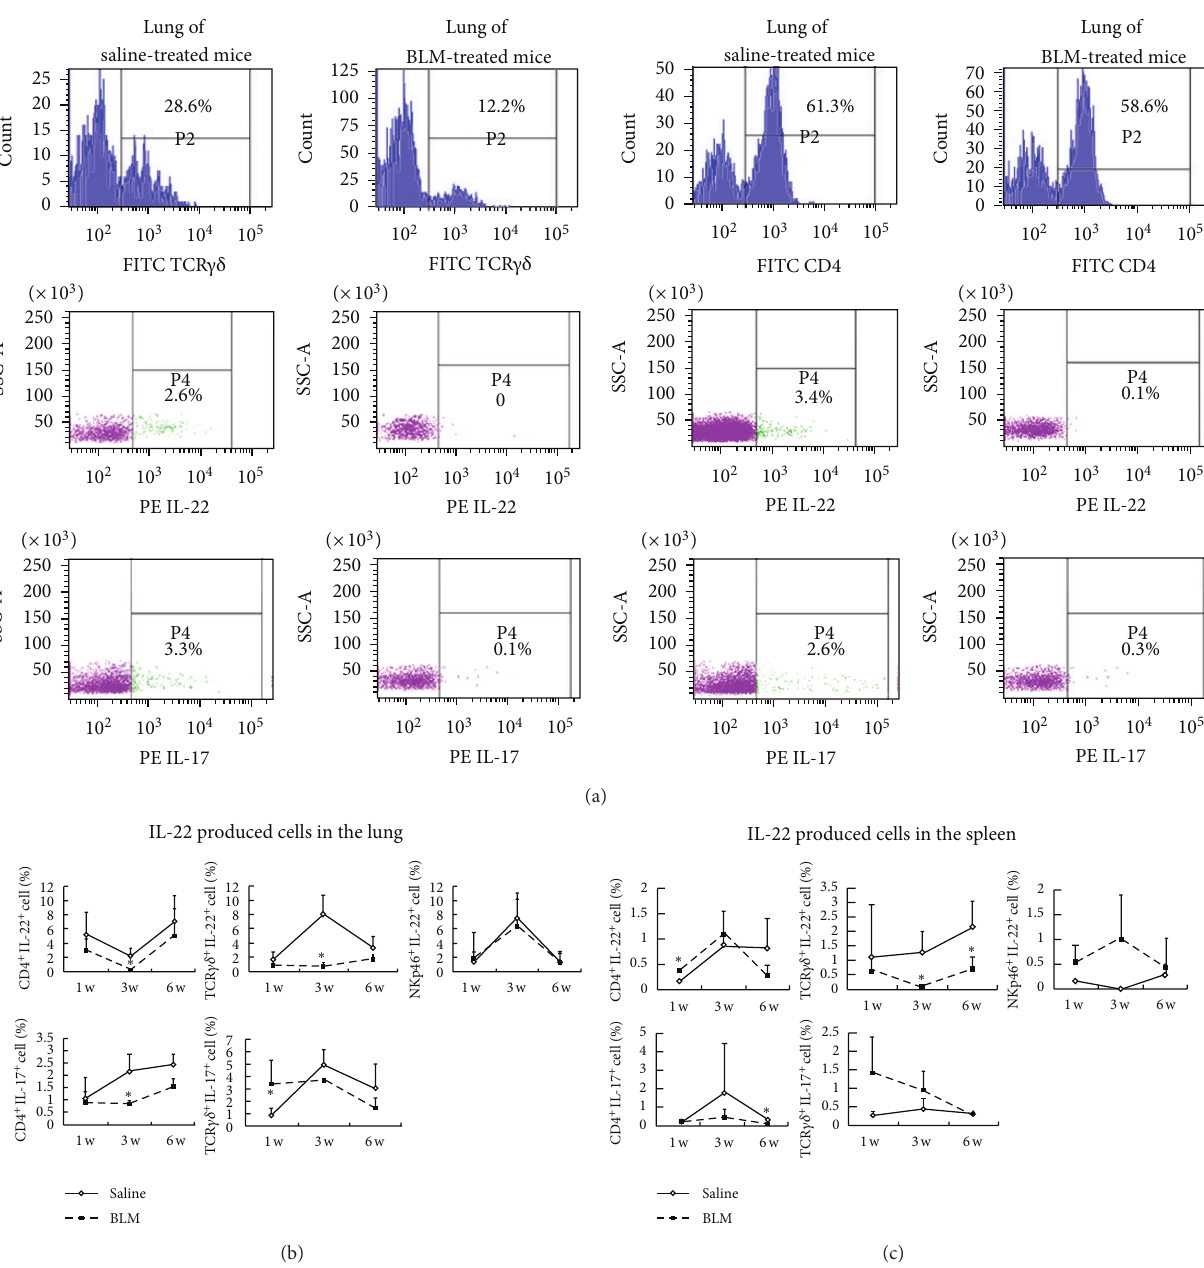
Figure 3: Infiltration of IL-22/IL-17 produced cells in the lungs and spleens induced by intratracheal injections of bleomycin (BLM). Representative flow cytometry pictures of CD4 + IL-22 + and TCR 𝛾𝛿 + IL-22 + cell from the lung and spleen tissues at the 3rd week were shown in Figure 1(a). And the percentages of CD4 + IL-22 + , TCR 𝛾𝛿 + IL-22 + , NKp46 + IL-22 + , CD4 + IL-17 + , and TCR 𝛾𝛿 + IL-17 + cells in the lungs (b) and spleens (c) were counted by flow cytometry analysis at the indicated week (w). Data presented in (b) and (c) are from two independent experiments with 8 ∼ 10 mice in each group. Values are the mean and SEM. ∗ 𝑃 < 0.05